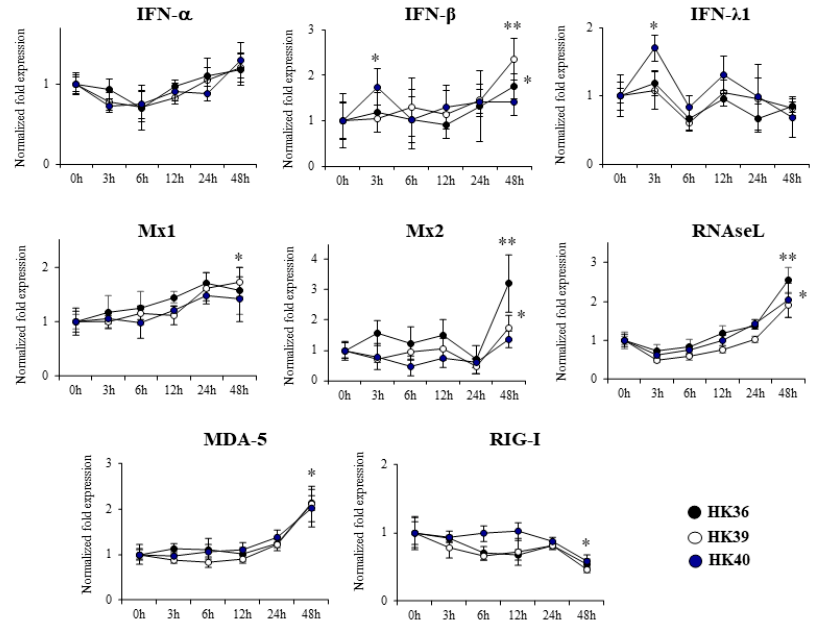
Figure 4. Effect of non-viable Lactobacillus gasseri strains on the expression of interferons and interferon-induced antiviral genes in porcine alveolar macrophages. Alveolar macrophages were stimulated with non-viable L. gasseri TMT36 (HK36), TMT39 (HK39), or TMT40 (HK40) and the expression of IFN- α , IFN- β , IFN- λ 1 , RNAseL , Mx1 , Mx2 , MDA-5 and RIG-I were analyzed by qPCR at the indicated time points. The results represent data from three independent experiments. Signif- icant differences were observed to unchallenged control porcine alveolar macrophages (time 0 h). * ( p < 0.05), ** ( p < 0.01).